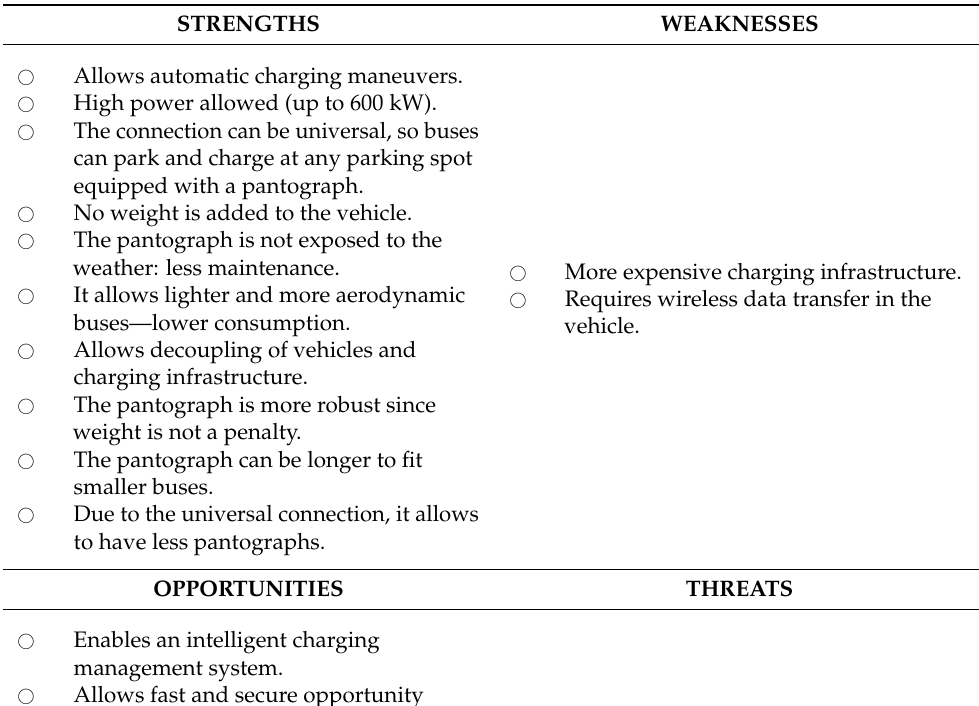
Table 6. SWOT analysis of Traditional inverted pantograph or panto-down. STRENGTHS